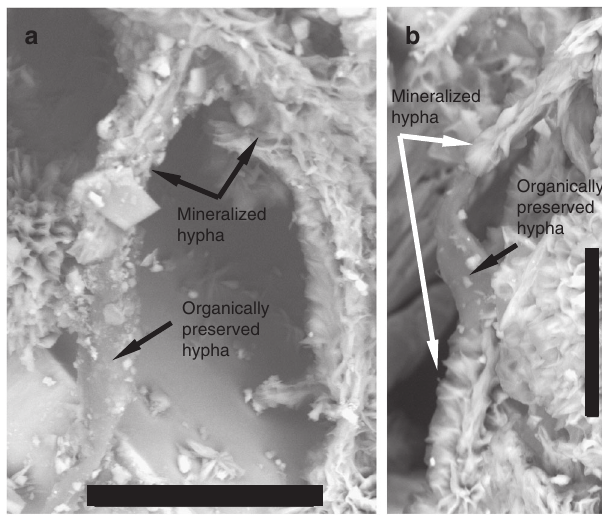
Fig. 4 Gradual transition between organically preserved and mineralized hyphae. Back-scattered Environmental Scanning Electron Microscopy (ESEM)-images. Scale bars are 50 µ m ( a ) and 30 µ m ( b left to right). This is followed by a generation strongly depleted in 13 C ( − 43 to − 26 ‰ ) and with highest δ 18 O ( − 11 to − 4.4 ‰ ), whereas the youngest generation with δ 13 C of − 24 to − 16 ‰ and δ 18 O of − 15 to − 11 ‰ (Fig. 7b, e) is most affected by microorganism-related chemical weathering. Single phase liquid fl uid inclusions in the calcite (Supplementary Fig. 3) indicate